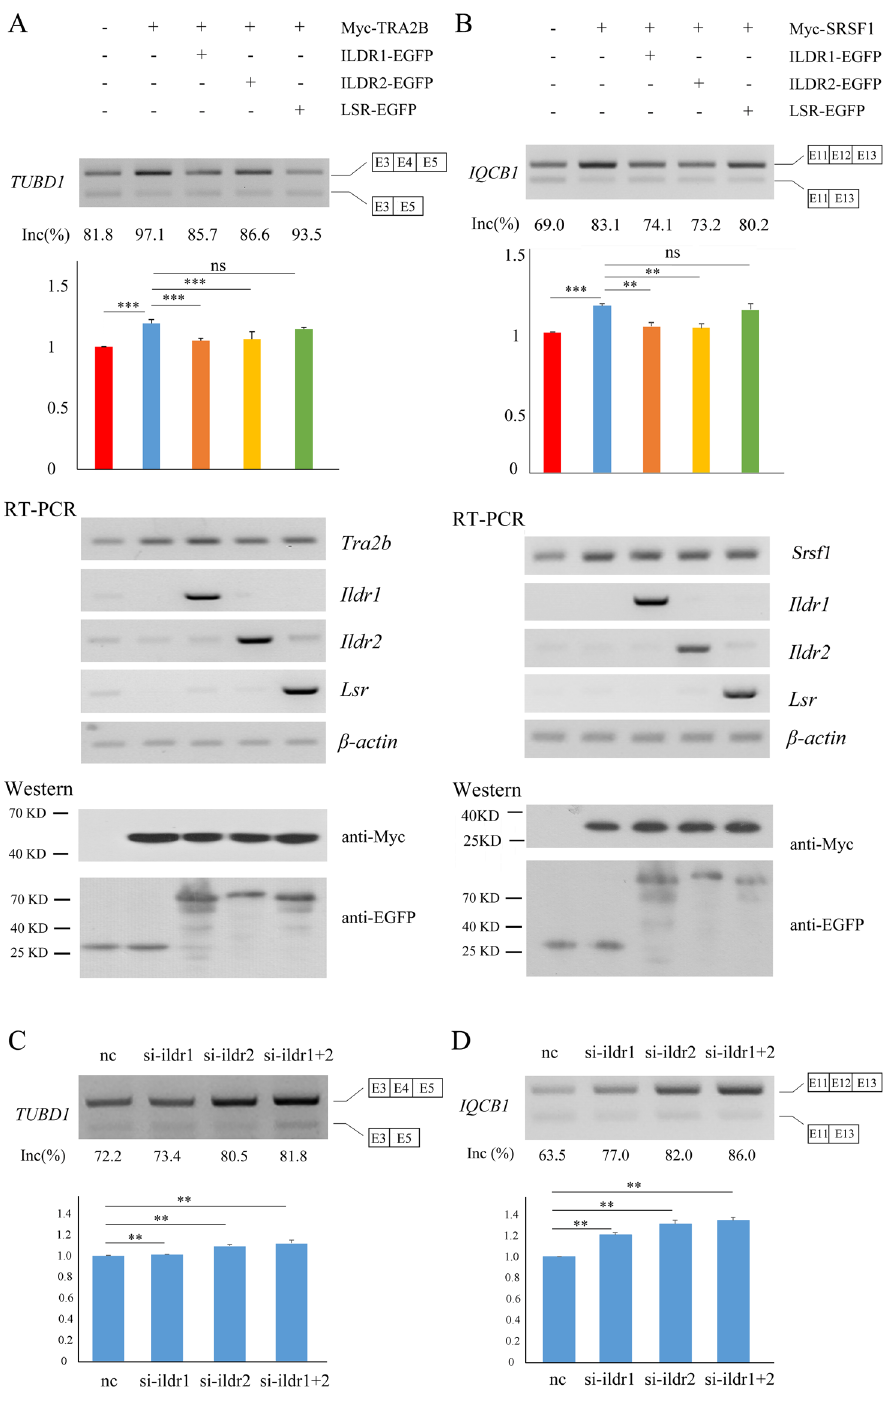
Figure 6. ILDR2 affects TUBD1 and IQCB1 pre-mRNA splicing. ( A ) RT-PCR revealed that exon 4 of endogenous TUBD1 in HEK293T cells is subjected to alternative splicing (lane 1). The inclusion of exon 4 was enhanced by TRA2B (lane 2), whose effect was inhibited by ILDR1 (lane 3) or ILDR2 (lane 4), but not LSR (lane 5). The level of overexpression was examined via RT-PCR and Western blot. ( B ) RT-PCR revealed that exon 12 of endogenous IQCB1 in HEK293T cells is subjected to alternative splicing (lane 1). The inclusion of exon 12 was enhanced by SRSF1 (lane 2), whose effect was inhibited by ILDR1 (lane 3) or ILDR2 (lane 4), but not LSR (lane 5). The level of overexpression was examined via RT-PCR and Western blot. ( C ) RT-PCR revealed that the inclusion of exon 4 of TUBD1 in HEK293T cells was enhanced when ILDR1 and/or IDLR2 were knockdown. ( D ) RT-PCR revealed that the inclusion of exon 12 of IQCB1 in HEK293T cells was enhanced when ILDR1 and/or IDLR2 were knockdown. The relative exon inclusion rate was calculated from three independently performed experiments. The differences between groups were determined by Student’s t-test. ** P < 0.01; *** P < 0.001; ns, not